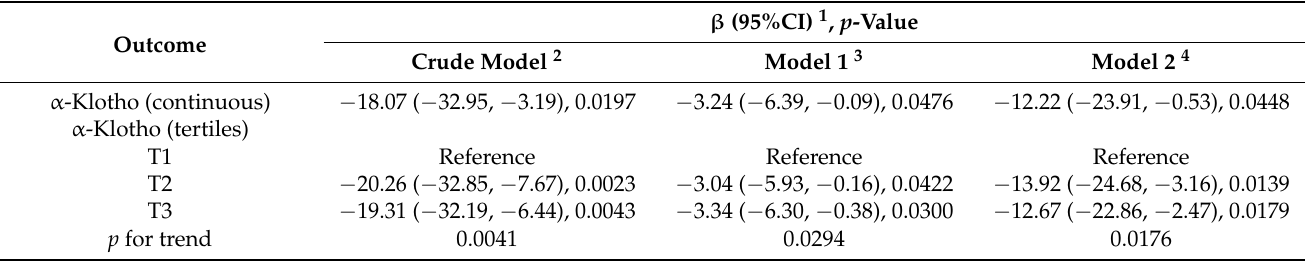
Table 2. Association between log2 α -Klotho and ACR.